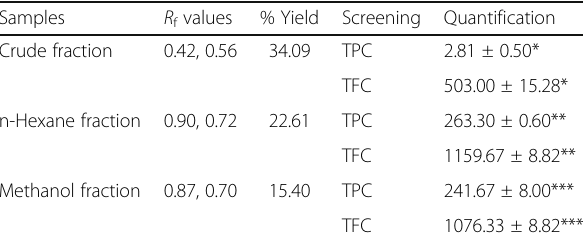
Table 1 Quantification and TLC analysis of bioactive compounds with antioxidant properties in A. vogelii